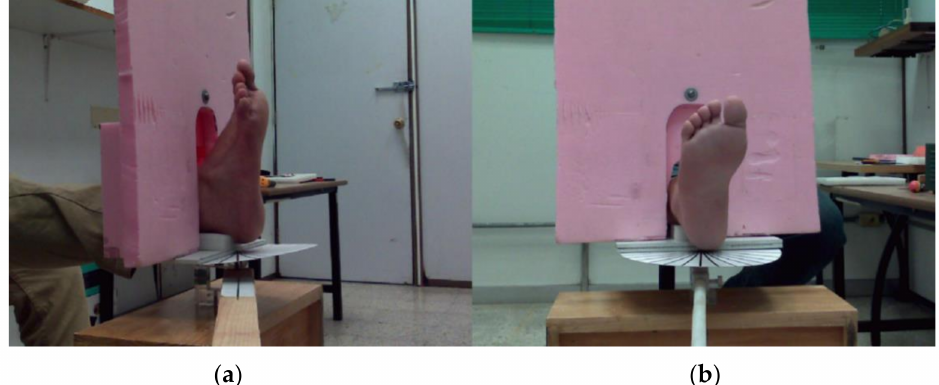
Figure 3. Foot posture during the image acquisition. ( a ) Lateral view of the foot on the resting base with angle and the thermal insulating foam background. ( b ) Frontal view. It is noteworthy that the pink background foam is large enough to isolate the foot from the remaining body of the volunteer so that the IR radiation does not interfere with the captured frame.